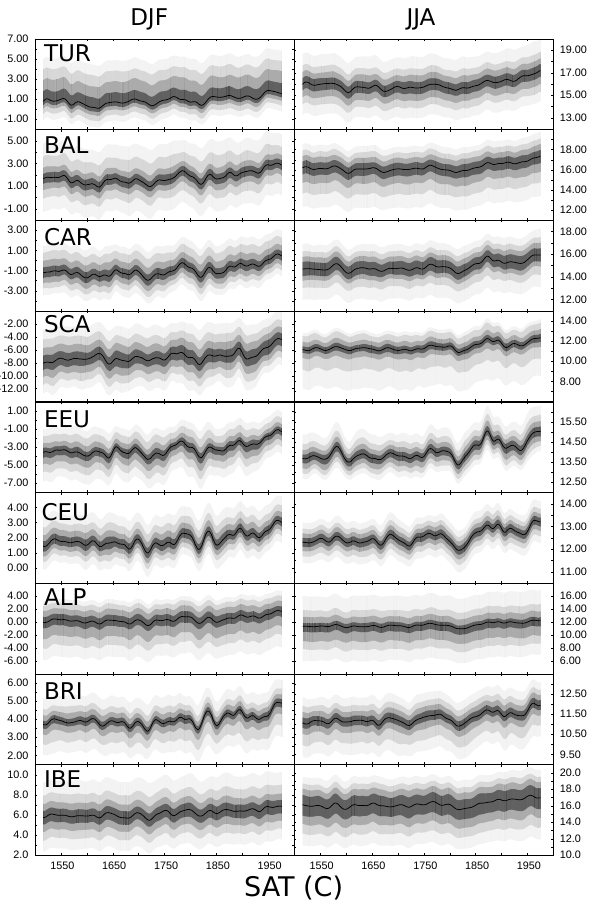
Fig. 13. Temporal series of precipitation quantiles in the nine areas considered in Fig. 2. The filled curves with different grey shading encompass the percentiles between 10 and 90 of the precipitation field in each time step, while the solid line represents the median. The series are smoothed through a Hamming window of 30 time steps to emphasise the low-frequency variability and facilitate the